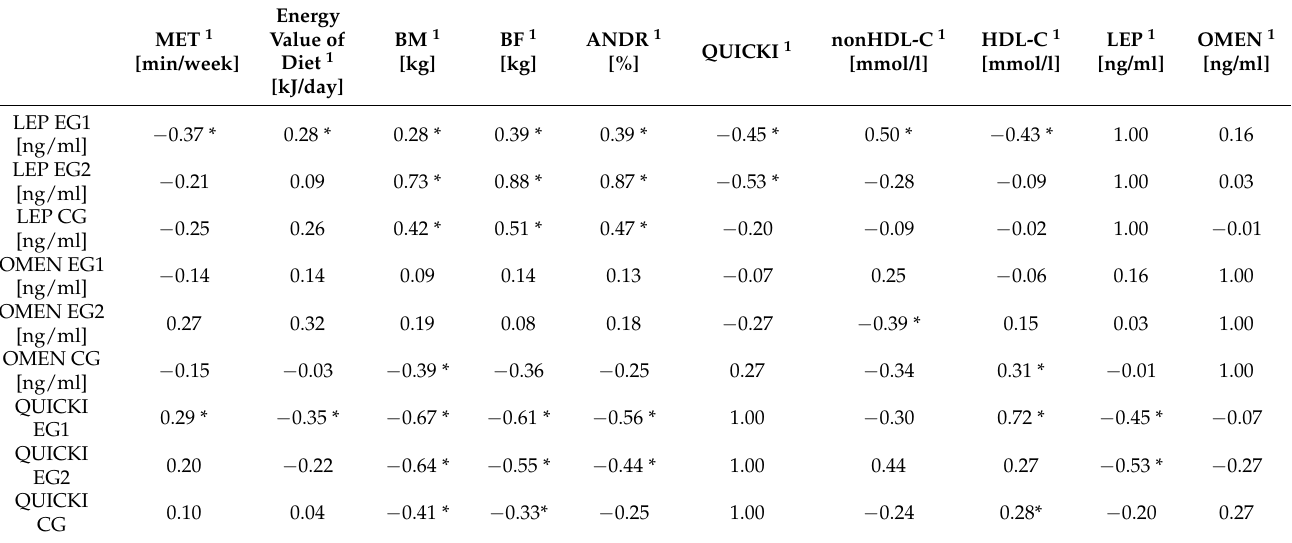
Table 5. The value of the Pearson correlation for variables in the aerobic group (EG1), aerobic- resistance group (EG2), and control group